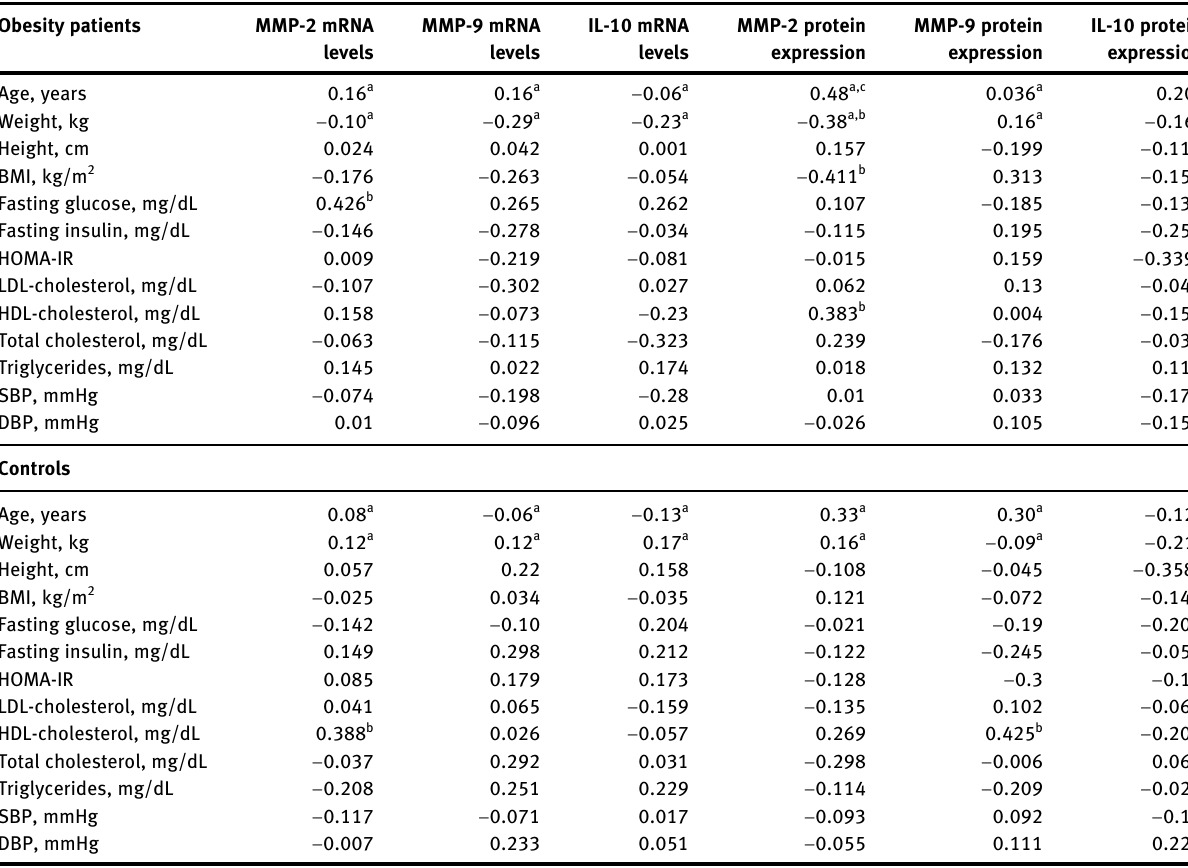
Table  : The correlation between MMP-  , MMP-  , IL-  expressions and anthropometric and biochemical characteristics of obesity patients and